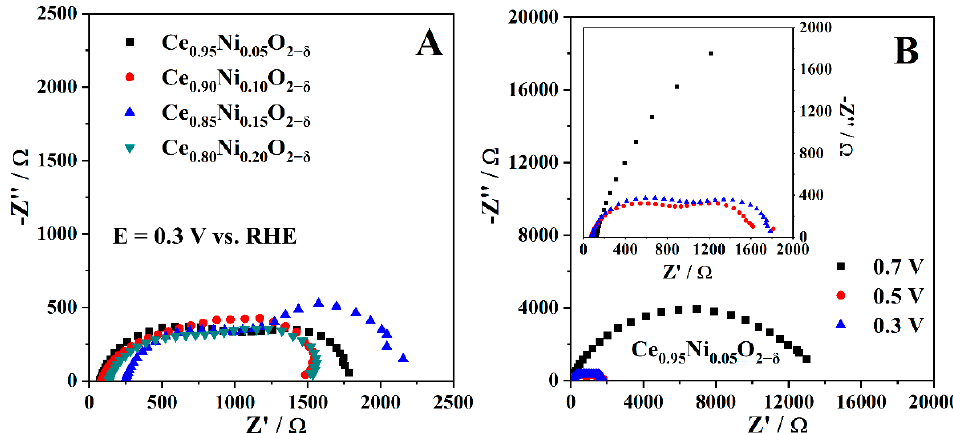
Figure 3. Nyquist plots of ( A ) Ce 0.95 Ni 0.05 O 2 − δ , Ce 0.90 Ni 0.10 O 2 − δ , Ce 0.85 Ni 0.15 O 2 − δ , and Ce 0.80 Ni 0.20 O 2 − δ at a potential of 0.3 V and of ( B ) Ce 0.95 Ni 0.05 O 2 − δ at potentials of 0.7, 0.5, and 0.3 V, with the high-frequency region in the inset. Potential values are corrected for the ohmic drop in the electrolyte. Measurements carried out in O 2 -saturated 0.1 M KOH solution and electrode rotation rate of 1200 rpm.